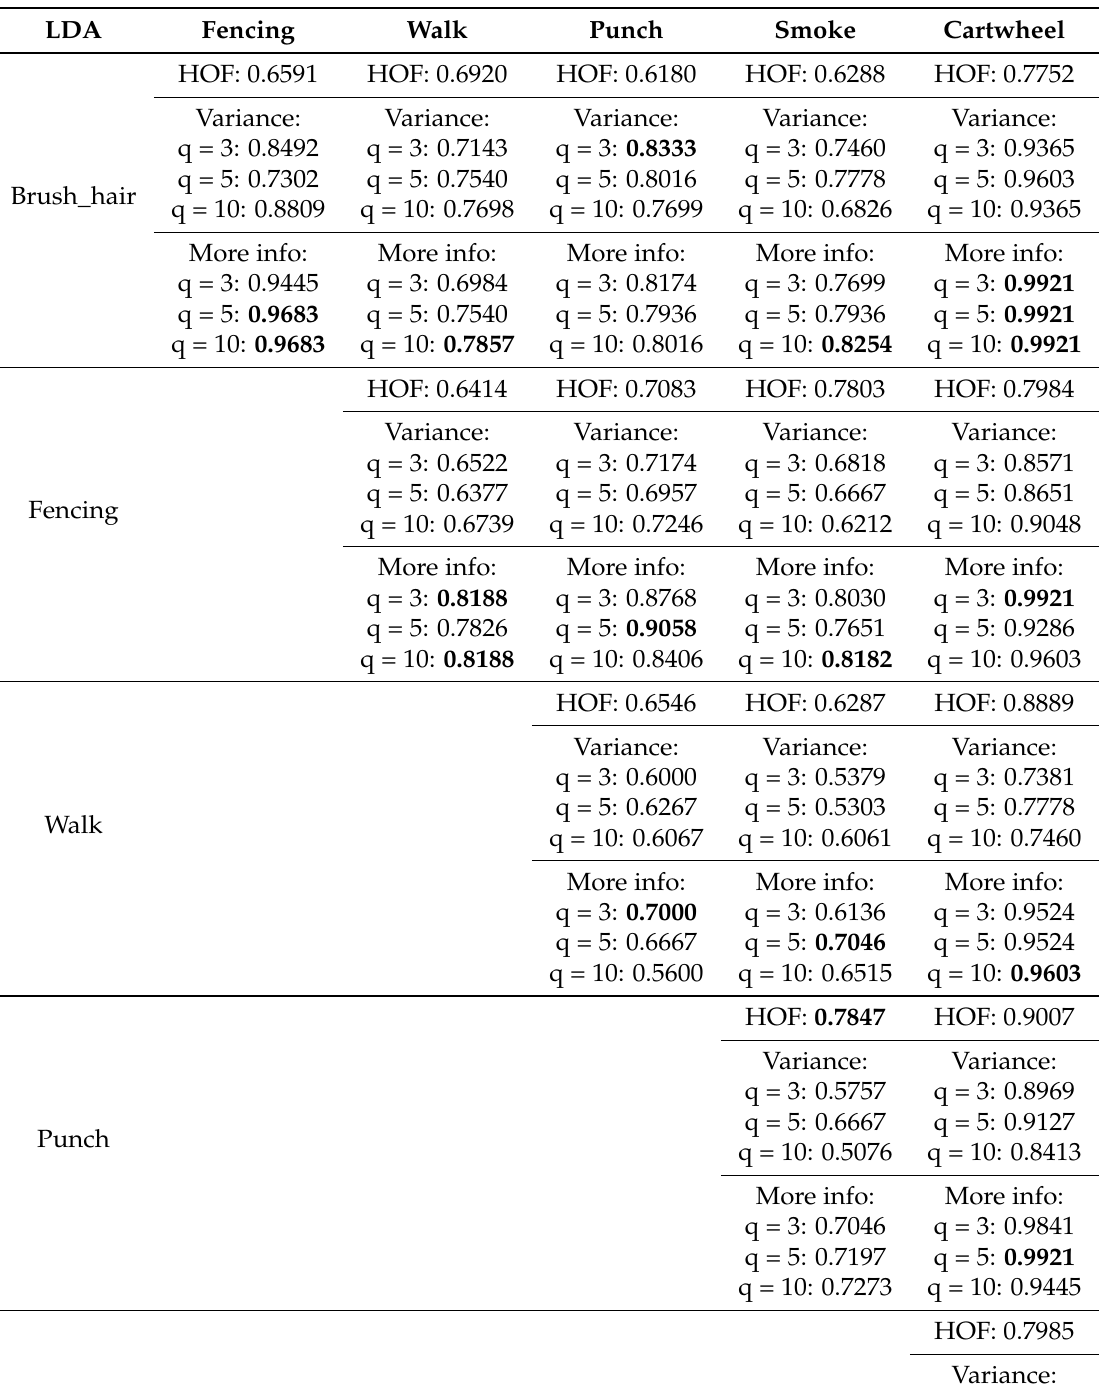
Table 3. Linear Discriminant Analysis (LDA) classifier results. LDA Fencing Walk Punch Smoke